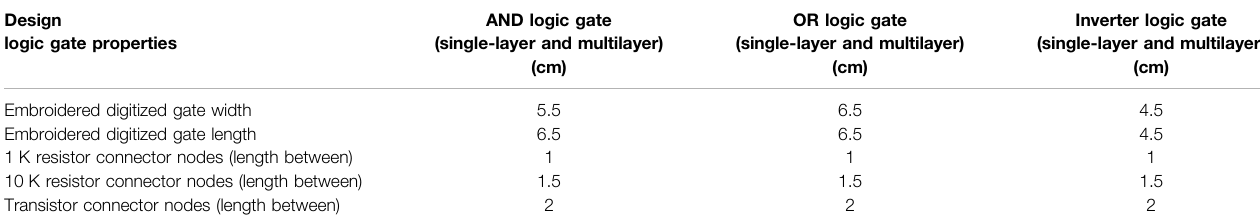
TABLE 1 | Logic gate measurements. Design logic gate